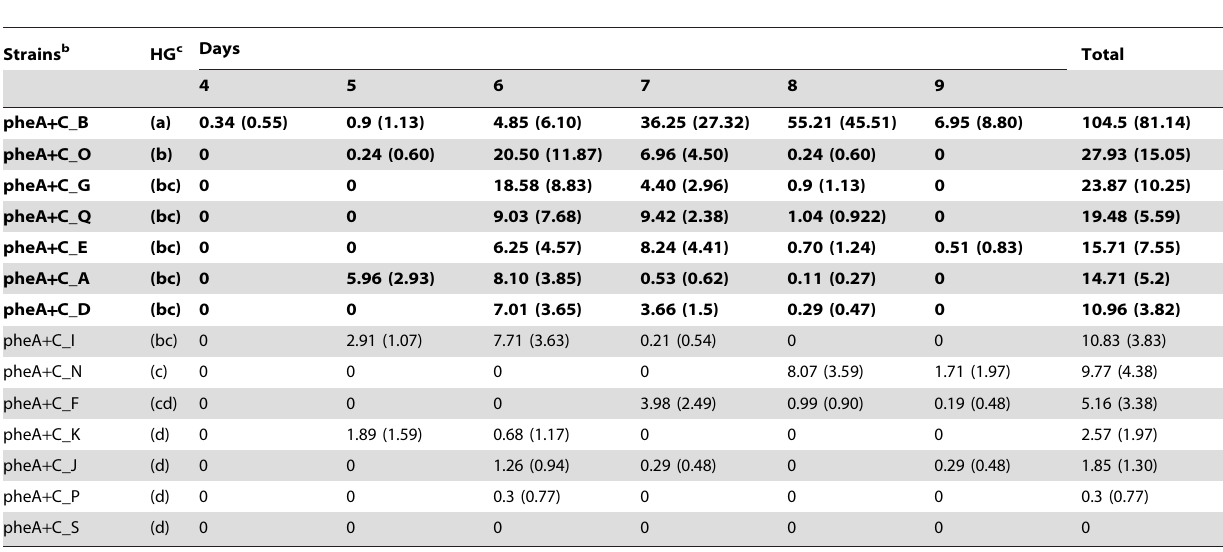
Table 2. The frequency of accumulation of Phe + mutants in P. putida strains carrying the pheA + C test system at different chromosomal locations a